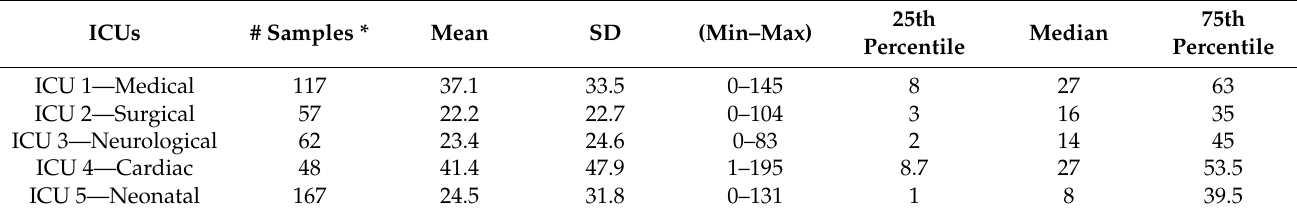
Table 4. Number of surface samples and average level of microbial contamination of surfaces (CFU/plate) by ICU. (#: